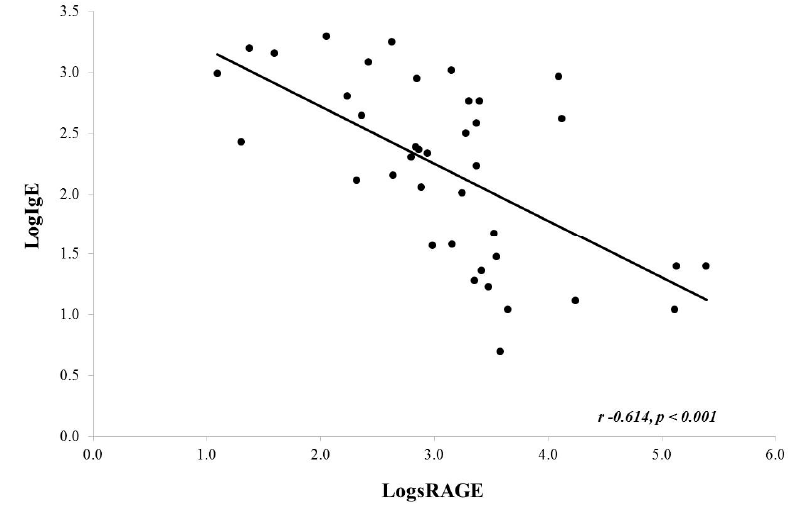
Figure 2. Correlation between serum IgE and BAL sRAGE. There was a significant negative correlation noted.